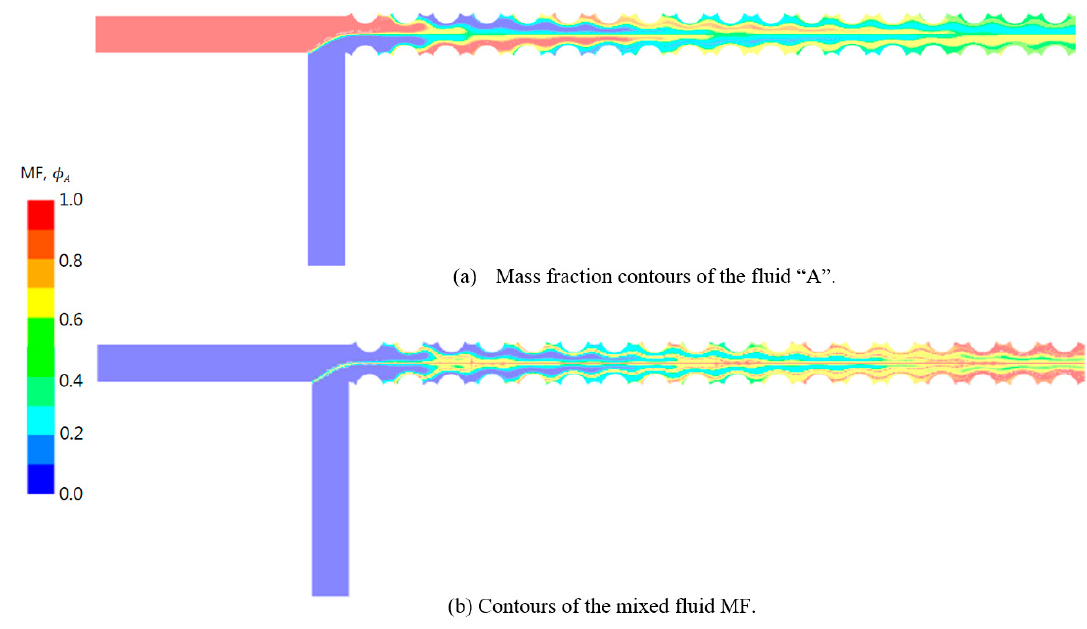
Figure 9. Contours of mass fraction of fluid A and the mixed fluid (MF) at the mid-section in the z -direction.